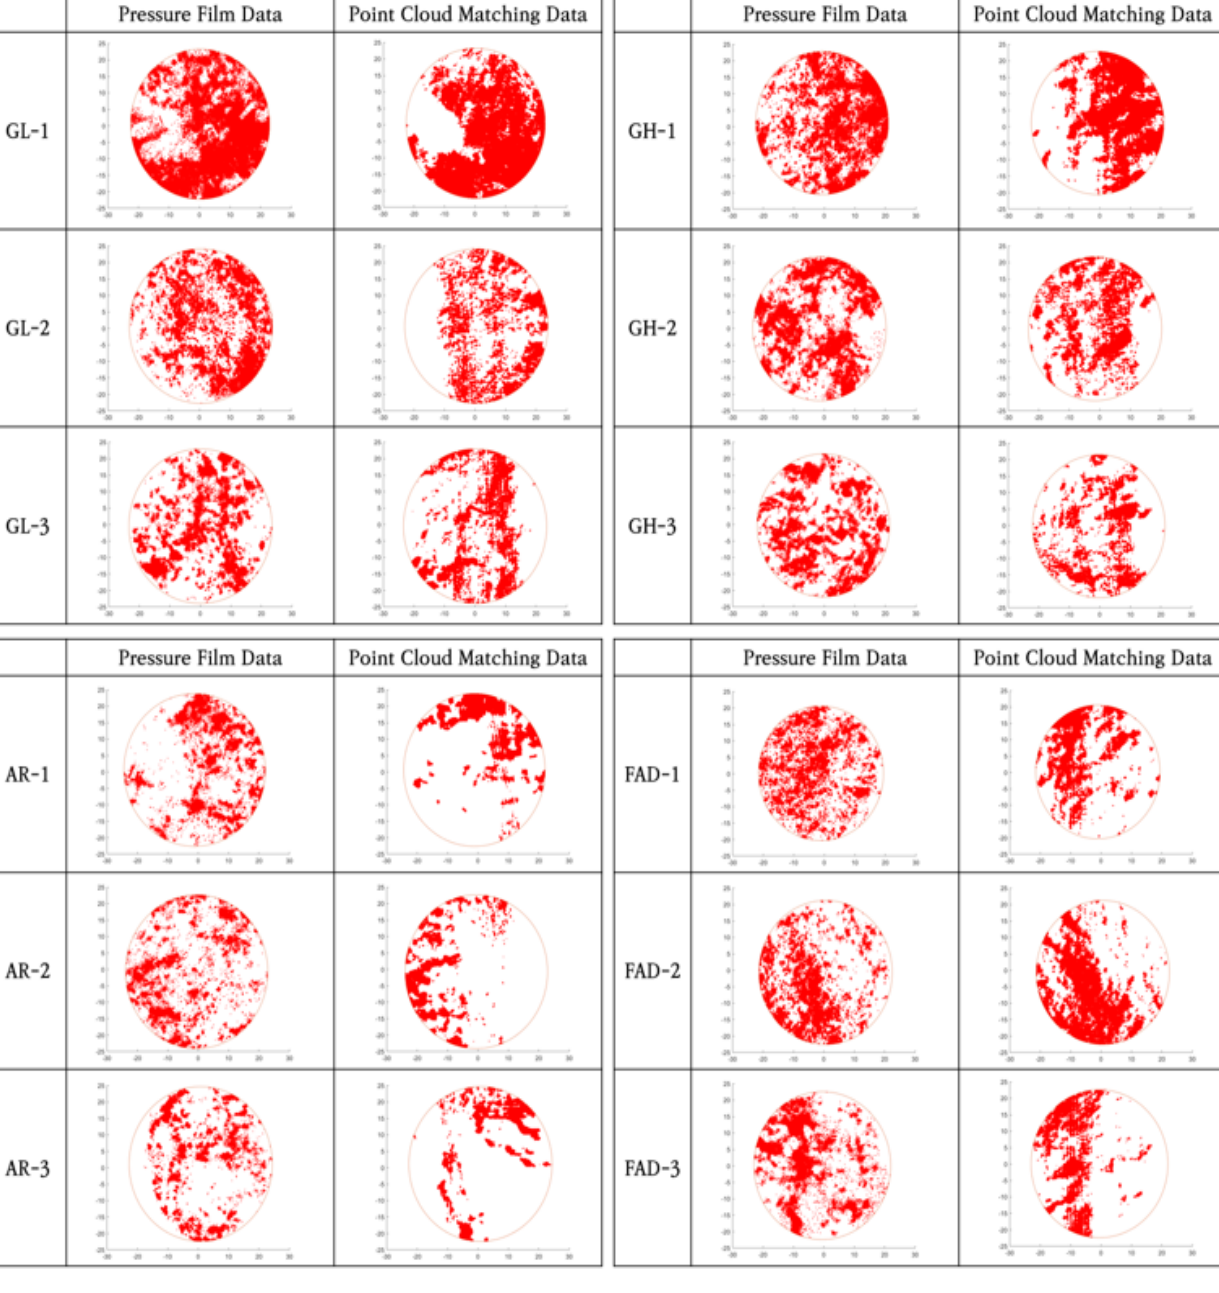
Figure 10. Comparison result of numerical data through the application of the matching algo- rithm.